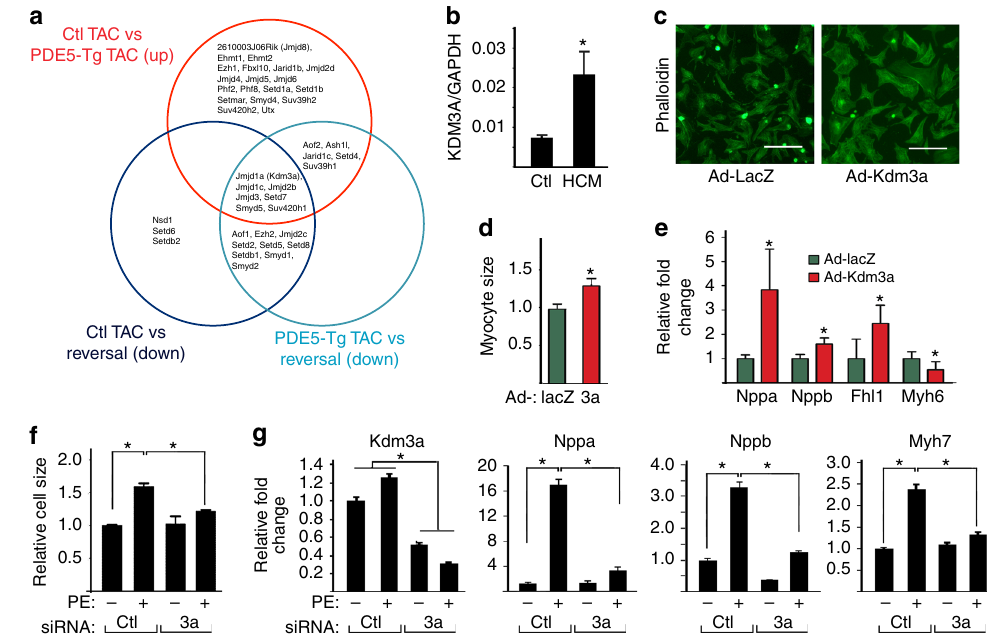
Fig. 1 KDM3A promotes cardiomyocyte hypertrophy in vitro. a Venn diagram showing differentially expressed genes that are involved in histone methylation and are either up or downregulated in PDE5-Tg versus control littermates, PED5-Tg treated with sildena fi l (Reversal) versus control littermates, and reversal versus PDE5-Tg mice after TAC. b KDM3A mRNA in human patients with hypertrophic cardiomyopathy (HCM) ( n = 5) and normal controls. * p < 0.05 ( t test). c Immuno fl uorescence micrographs of NRVMs transduced with adenoviruses expressing either LacZ or Kdm3a. Cells were stained with phalloidin. Scale bar, 100 μ m. d Relative cell size from cells in c . n = 3 ± SEM, * p < 0.05 ( t test). e Relative fold change of mRNA of gene associated with hypertrophic remodeling in NRVMs transduced with either Ad-LacZ or Ad-Kdm3a ( n = 3 ± SEM). mRNAs were normalized against internal Gapdh. * p < 0.05 ( t test). f – g NRVMs were transfected with control siRNA or Kdm3a speci fi c siRNA, treated with or without PE. Cells were fi xed and stained with phalloidin for measurement of cell size ( g ) or harvested for measurement of relative mRNA of Kdm3a and fetal gene markers ( g ). mRNA were normalized against internal GAPDH. n = 3 ± SEM, * p < 0.05